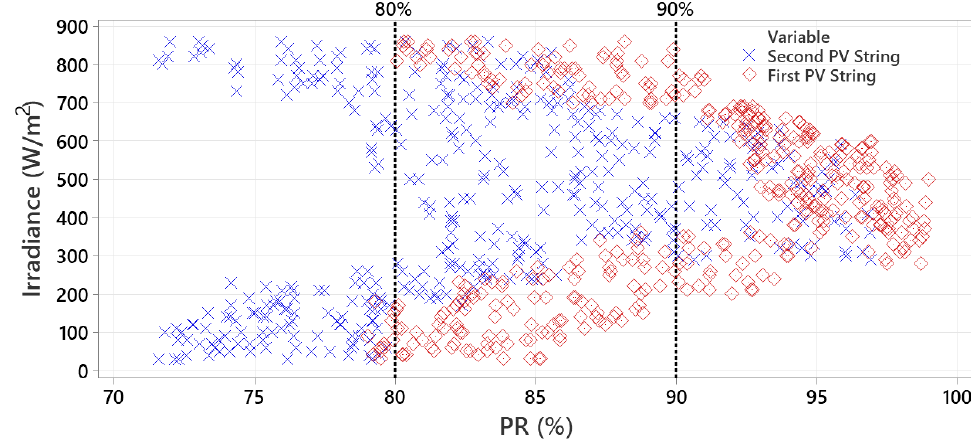
Figure 9. Correlation between solar irradiance and the PR ratio for the examined PV strings.